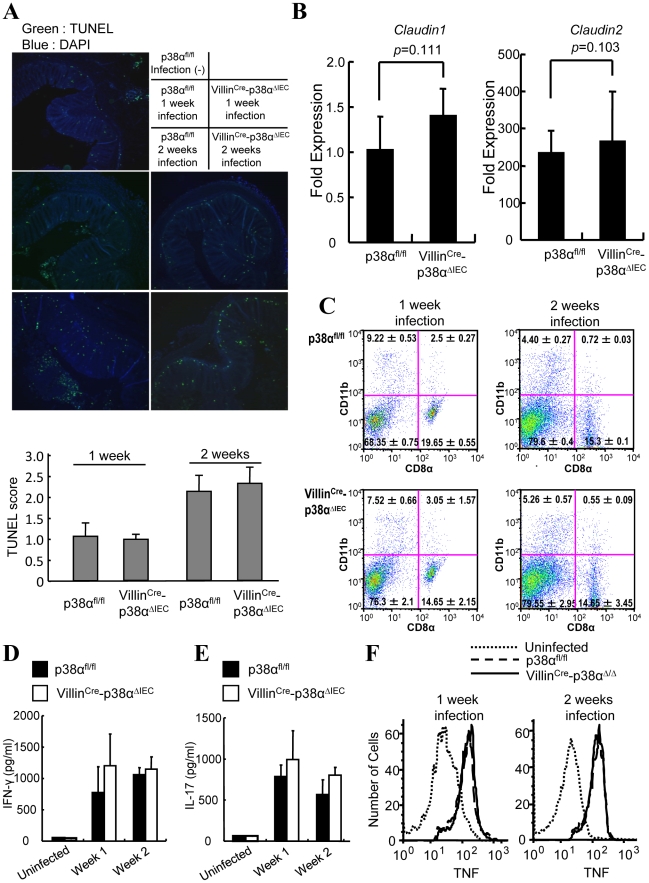
Epithelial integrity and immune cells are normal in VillinCre-p38αΔIEC mice after C. rodentium infection.
A, TUNEL staining (green) on colon cross sections from non-infected p38αfl/fl control and p38αfl/fl or VillinCre-p38αΔIEC mice at 1 and 2 weeks after infection. Scale bar, 100 µm. The sections were adjacent to those in Fig. 1C. B, Expression of tight junction proteins in the intestinal epithelial cells of C. rodentium-infected mice. Expression of Claudin-1 and -2 was measured by qPCR method. Fold expression of proteins was calculated over the expression of proteins of uninfected IECs. GADPH levels was measured as an internal control. C, Composition of the dendritic cell compartment in the mesenteric lymph node cells of p38αfl/fl or VillinCre-p38αΔIEC mice at 1 and 2 weeks after infection. D & E, C. rodentium-specific IFN-γ (D) and IL-17 (E) responses after restimulation of mesenteric lymph node cells from p38αfl/fl or VillinCre-p38αΔIEC mice at 1 and 2 weeks after infection. Data are representative of three independent experiments (n = 3). Cells from uninfected mice were used as a control. F, Expression of TNF-α by the macrophages (F4/80 positive cells) of the draining mesenteric lymph nodes of p38αfl/fl or VillinCre-p38αΔIEC mice at 1 and 2 weeks after infection. Data are representative of two independent experiments (n = 3).